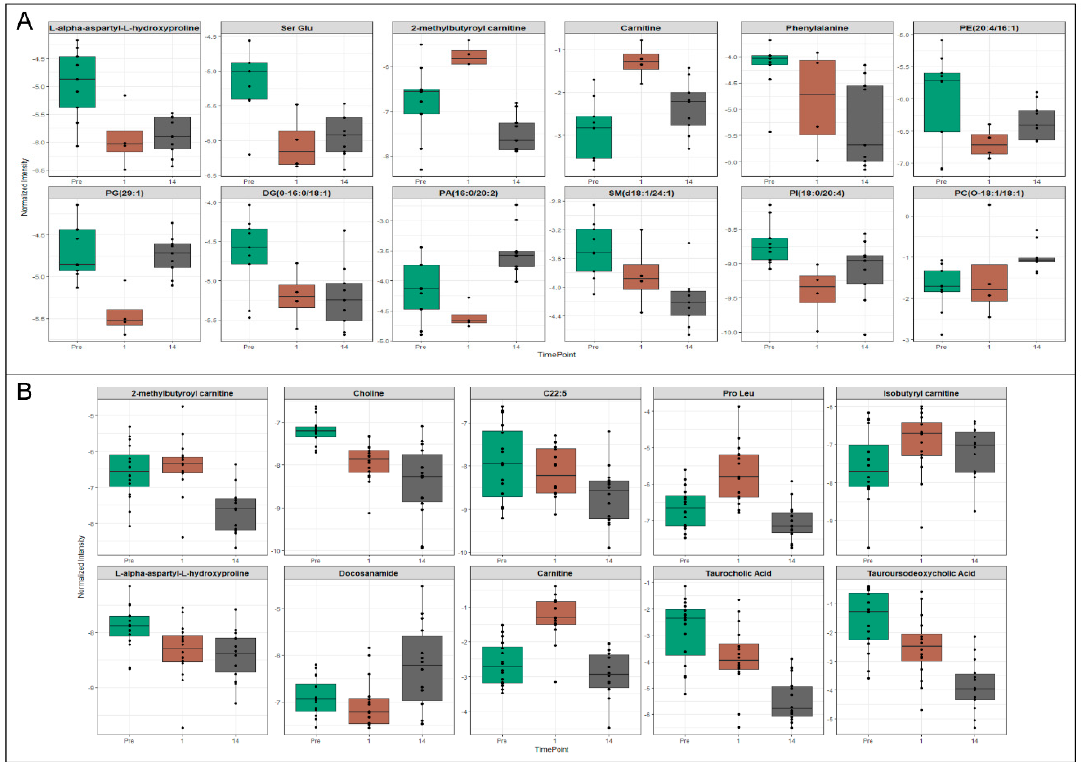
Figure 5. Significantly dysregulated biomarkers in plasma of NHPs exposed to 60 Co γ -radiation. Select biomarkers that were putatively annotated in plasma samples from NHPs exposed to either 5.8 Gy ( A ) or 6.5 Gy ( B ) 60 Co γ -radiation. Potential biomarkers for radiation damage were significantly changed and unique to plasma profiling including Carnitine, Ser-Glu, Choline, isobutyryl carnitine and L-alpha-aspartyl-L-hydroxyproline.